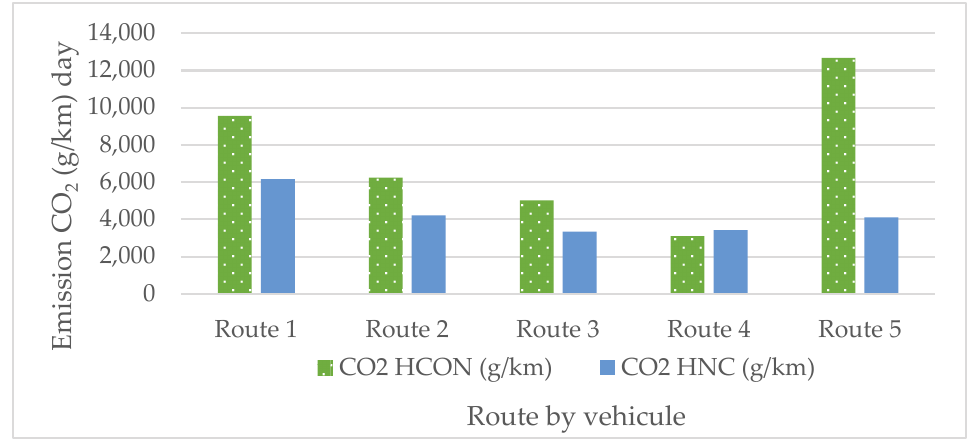
Figure 7. CO 2 emission in HCON and HNC.